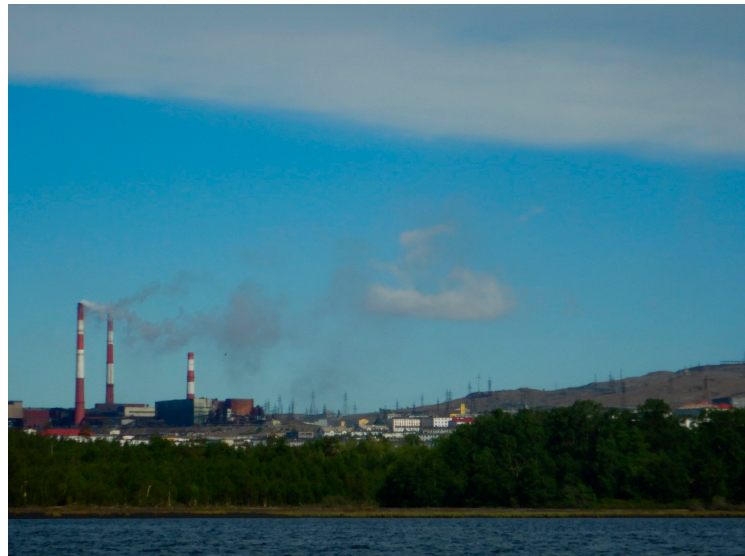
Figure 5. The view of Kola Mining and Metallurgical Company, “Pechenganickel” combine (photo by the author). Lake Kuetsjarvi is in the foreground.